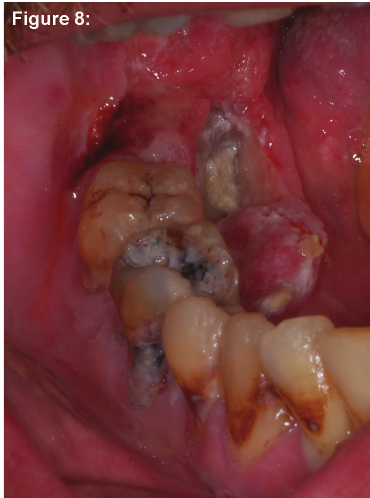
Figure 8: Case 3—clinical situation. A partially ulcerous tumour formation covered the lingual aspect of the alveolar crest adjacent to the two distal molars (46 and 47). Nearly all teeth of this quadrant show clearly the sequelae of nearly nonexistent oral hygiene habits. Striae of leukoplakia are found on the wall of the ulcer, the tongue, and also along the vestibular papillae.